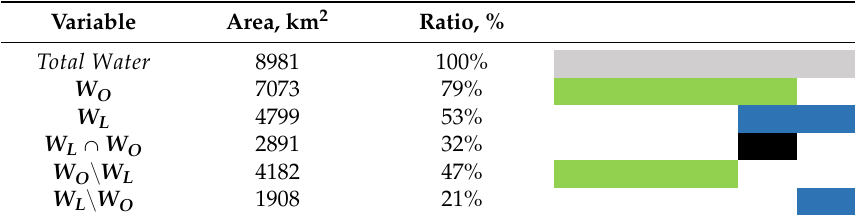
Table 2. Overlap between surface water detected using OSM and